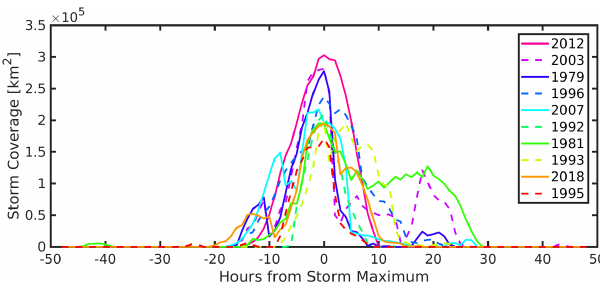
Figure 4. Spatial extent of the windstorms measured in square kilo- meters over the northeastern states using a time index relative to t p . The spatial extent is described as the area of ERA5 grid cells wherein the U>U 999 . Values are shown for 48h preceding and fol- lowing each windstorm peak.